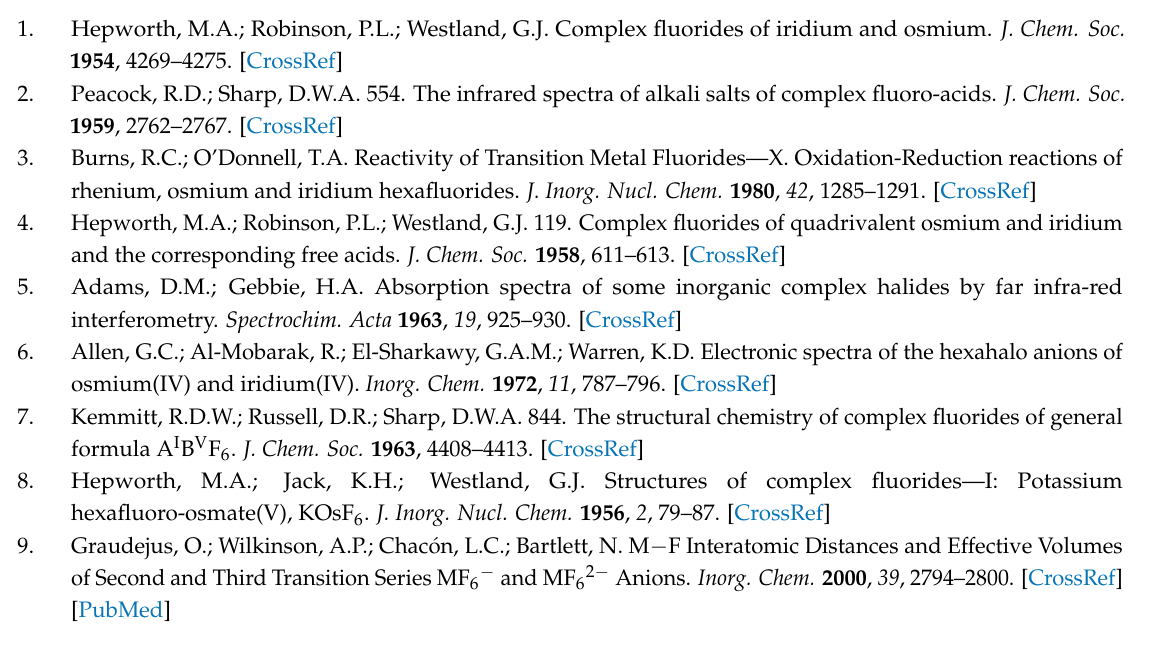
Figure S1: IR spectra of Ba(OsF 6 ) 2 : experimentally observed (black) and calculated with DFT-PBE0 (red), Figure S2: 19 F NMR spectrum of Ba(OsF 6 ) 2 in anhydrous HF, Table S1: Region assignment for the theoretical IR spectrum of Ba(OsF 6 ) 2 , Basis